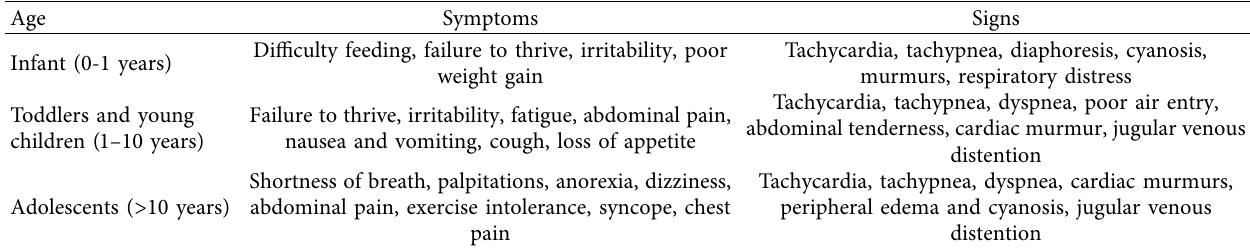
Figure 3: Modified parasternal short-axis view revealing a 2.7 × 1.3cm thrombus in the left Table 1: Signs and symptoms of heart failure in the pediatric patient population [14–16].